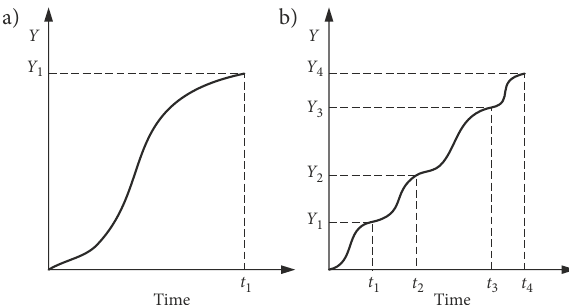
Figure 1. Two growth forms: a – single; b –